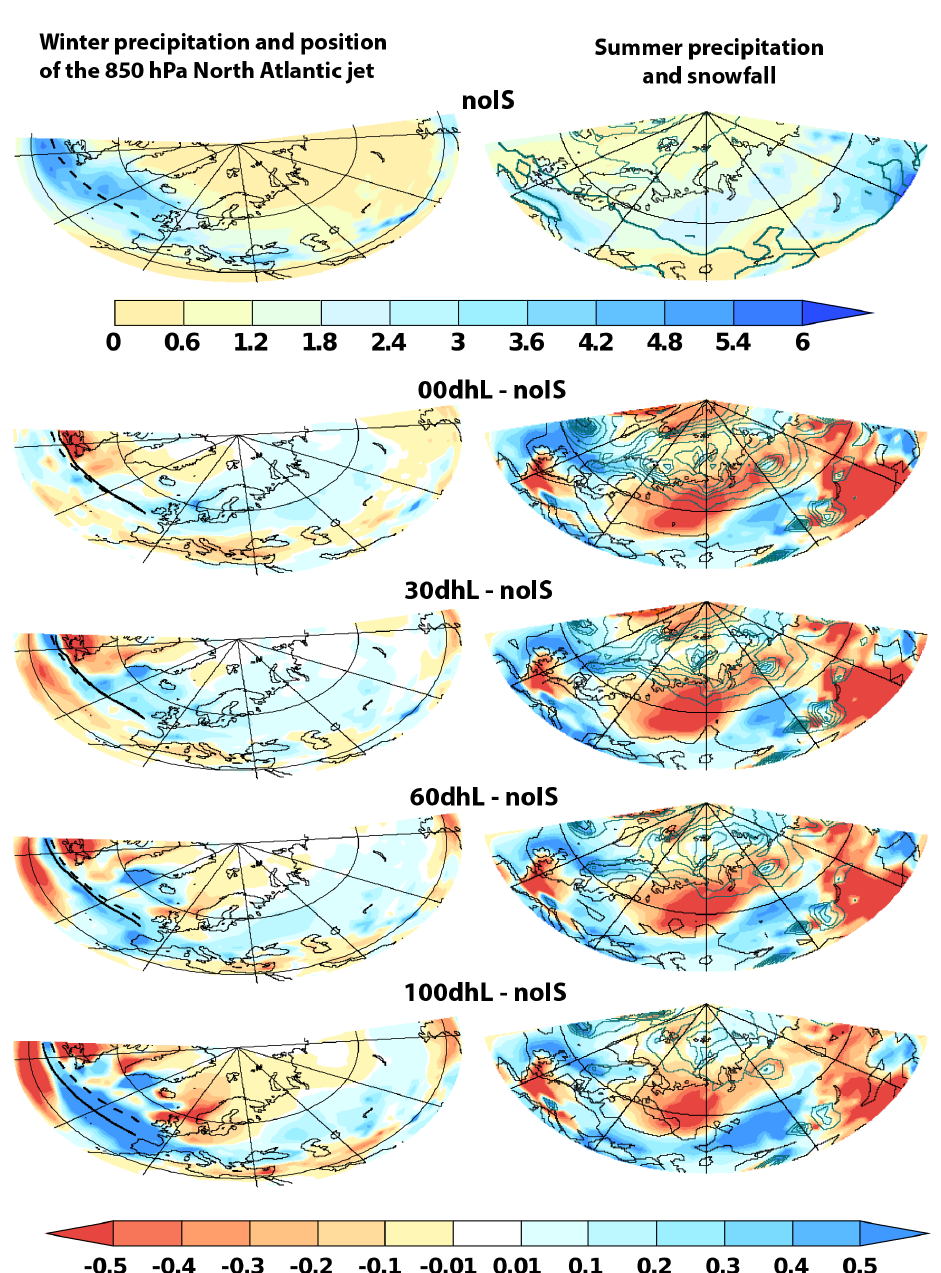
Figure 9. (shaded) and position of the North Atlantic jet stream without LIS (dashed) and for the xx dhL experiment (solid line). Right column: summer precipitation (shaded) and snowfall (contour every 0.1mmday − 1 , blue contour for positive